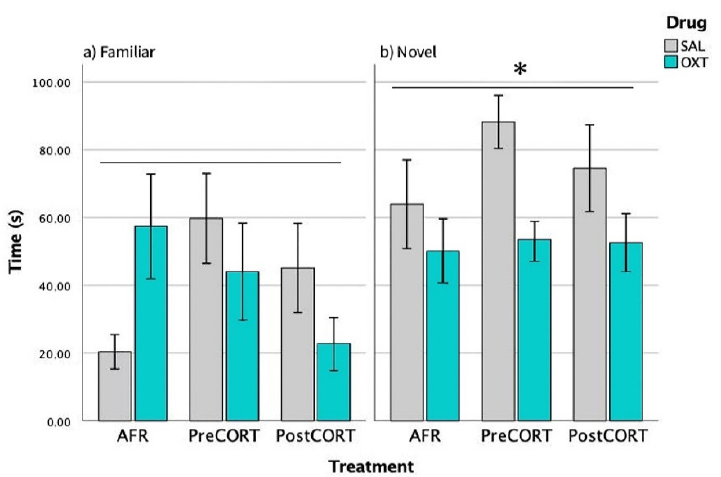
Figure 5. Sociability test, Episode 3. Comparison between time spent near the familiar vs. novel social stimulus. Subjects: AFR-SAL, AFR-OXT, PreCORT-SAL, PreCORT-OXT, PostCORT-SAL and PostCORT-OXT ( n = 8 for each group). During Episode 3, all mice exhibited a general preference for the novel social stimulus over the familiar one (* p < 0.05). Error bars indicate mean ±